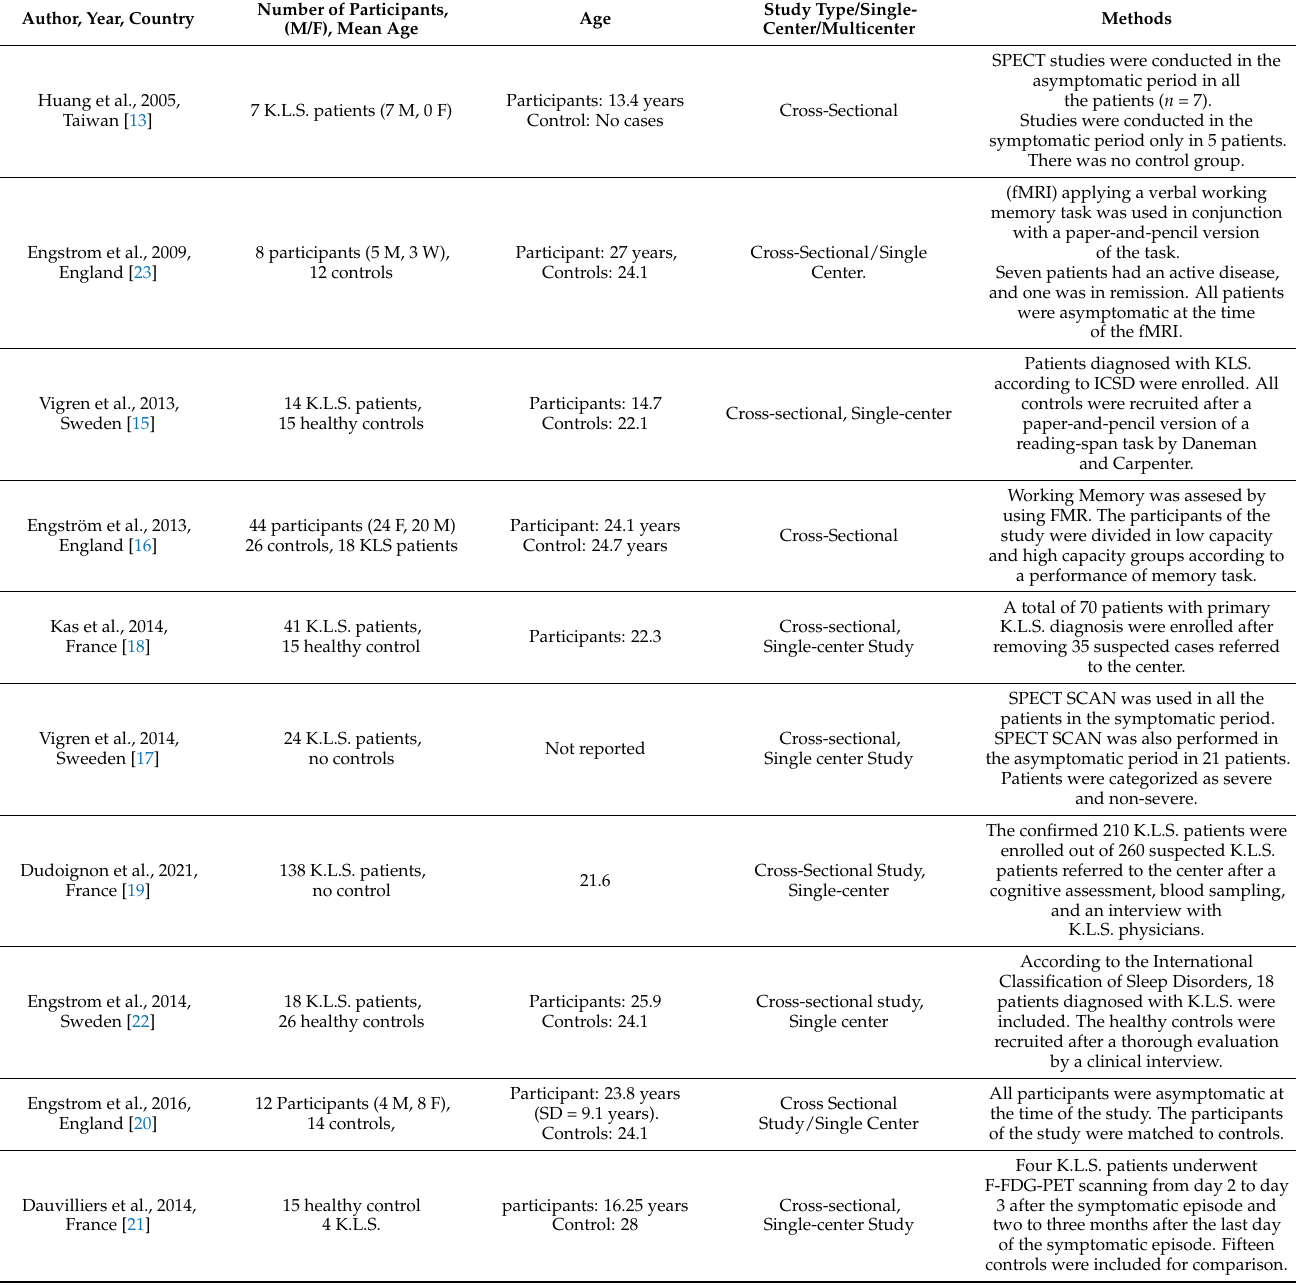
Table 2. Main characteristics of the